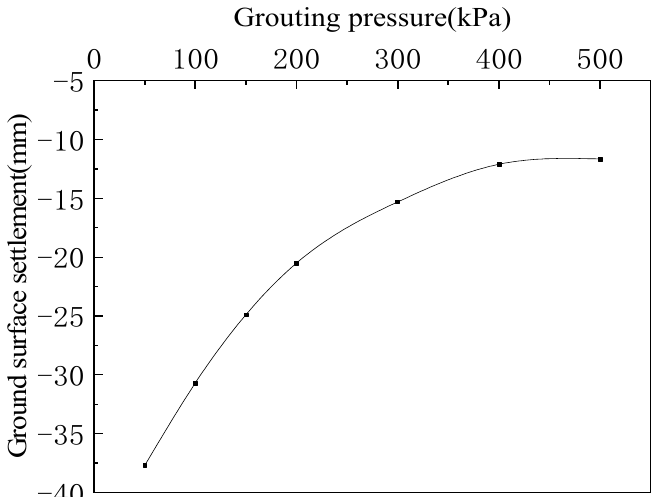
Figure 12. Curve of surface settlement with simultaneous grouting pressure.